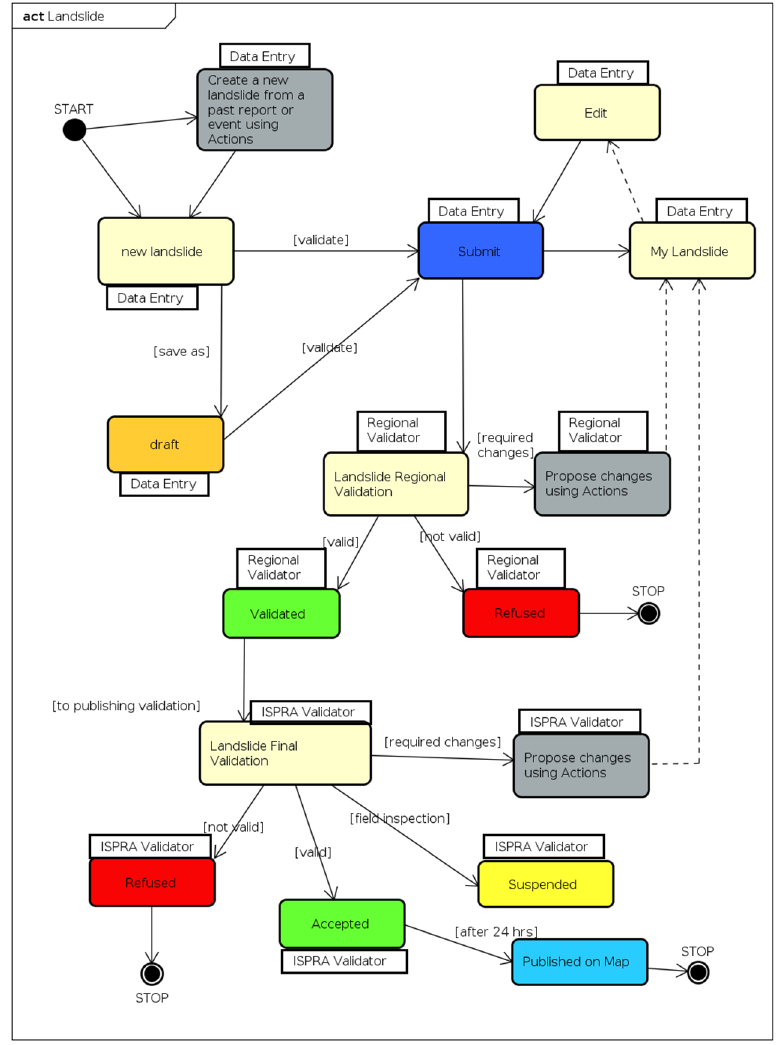
Figure 2. Landslide data management lifecycle diagram.